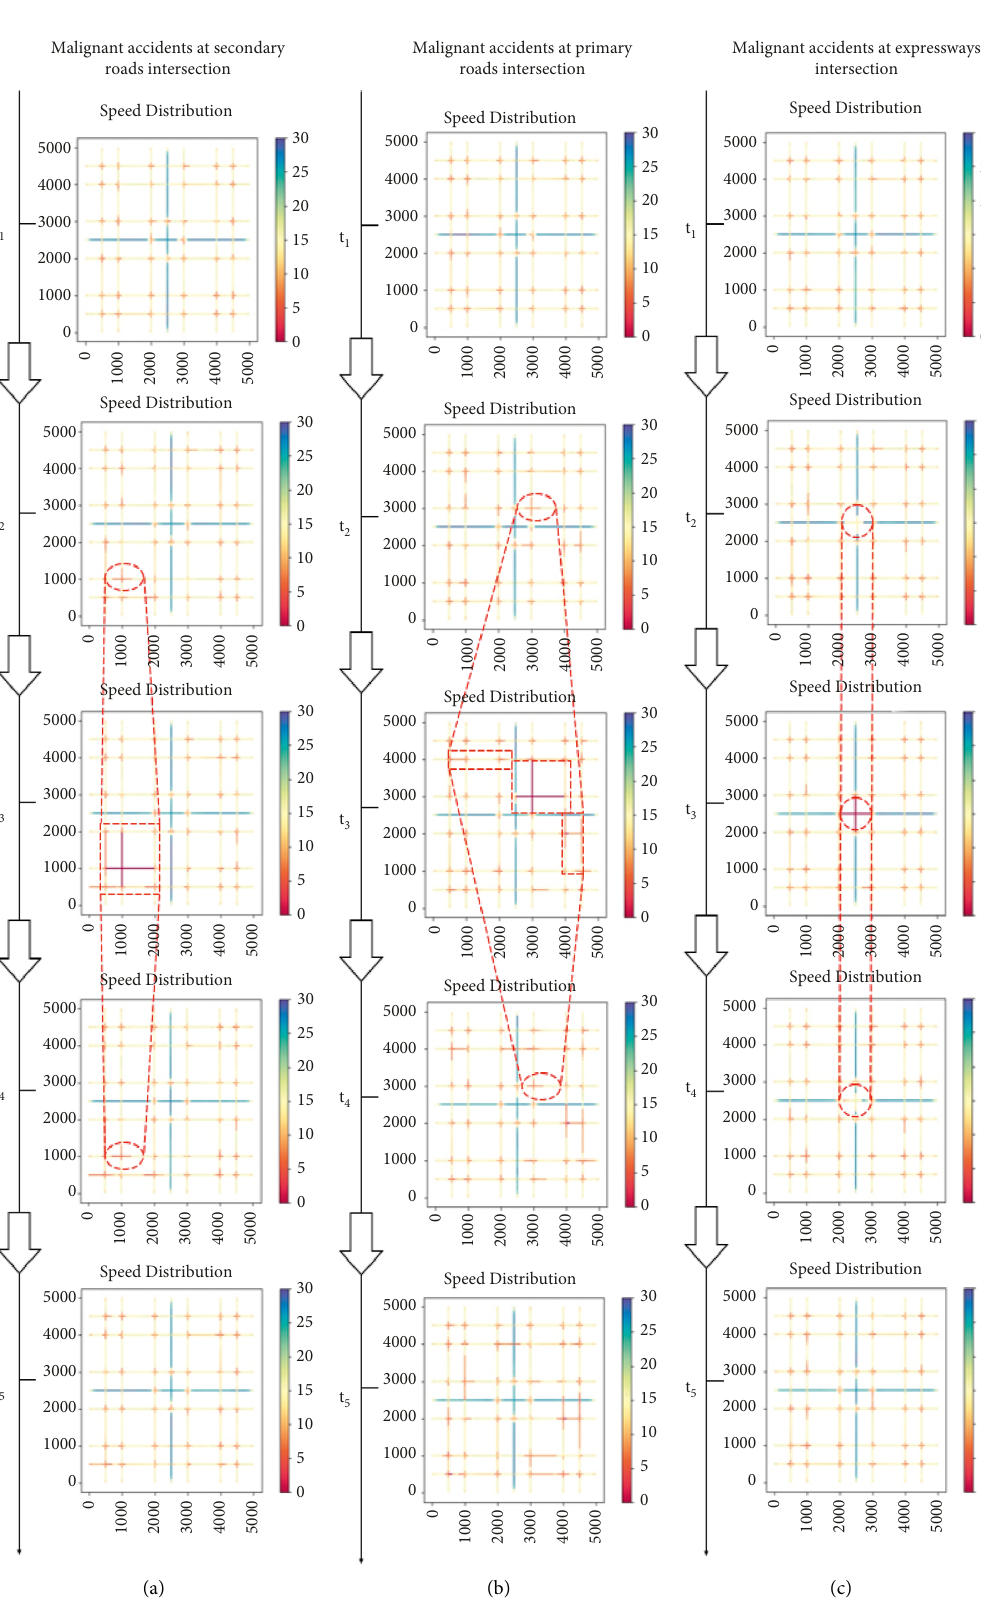
Figure 5: Spatial distribution of average speed with malignant accidents at (a) secondary roads intersection, (b) primary roads intersection, and (c) expressways